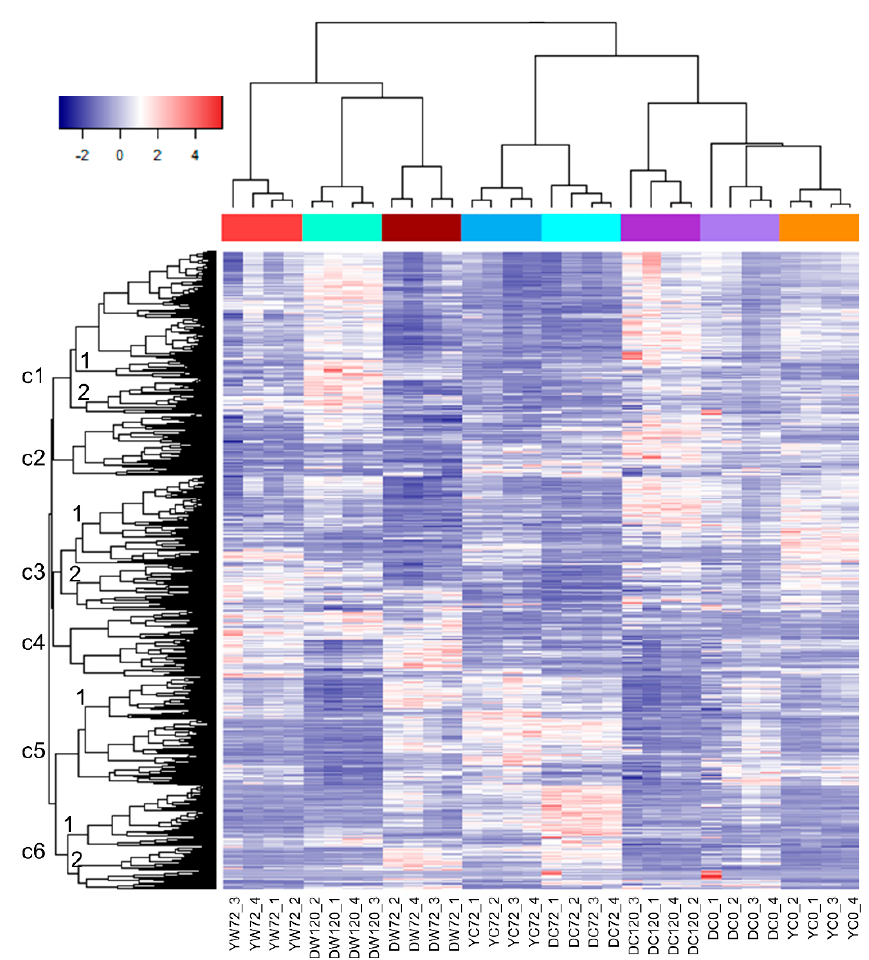
Figure 1. Cluster analysis of the genome-wide gene expression profiles of barley roots under waterlogging and control. Gene expression values (FPKM, fragments per kb transcript length per million reads of library size) were centralized by row using the Heatmap3 program. The genes were clustered by distances. The color scale in the above heatmap shows the expression level; blue indicates low transcript abundance while red indicates high abundance. YC0, Yerong 0 h control; YC72, Yerong 72 h control; YW72, Yerong 72 h of waterlogging; DC0, Deder2 0 h control; DC72, Deder2 72 h control; DC120, Deder2 120 h control; DW72, Deder2 72 h waterlogging; DW120, Deder2 120 h waterlogging.